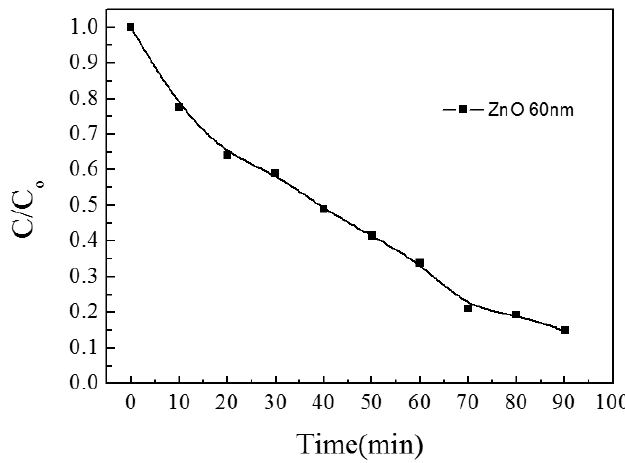
Figure 3. The photocatalytic activity of ZnO/glass complex films for different thickness.